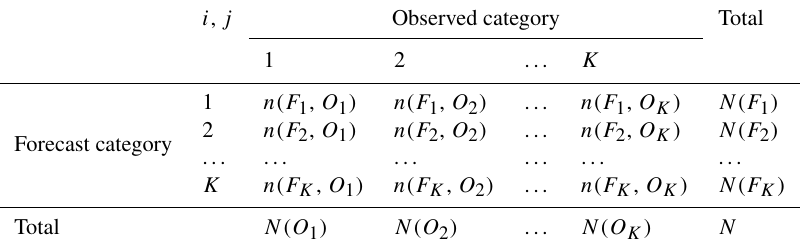
Table A2. K -category contingency table. n(F i , O j ) is the number of forecast/observed pairs for which the forecast is in category i and the observation in category j . N(F i ) indicates the total number of forecasts in the category i , N(O j ) indicates the total number of observations in the category j and N the total number of forecast/observed pairs. i , j Observed